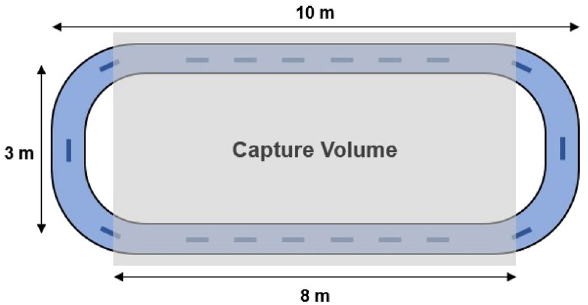
Figure 1. Schematic diagram of the walking path and motion-capture volume (not to